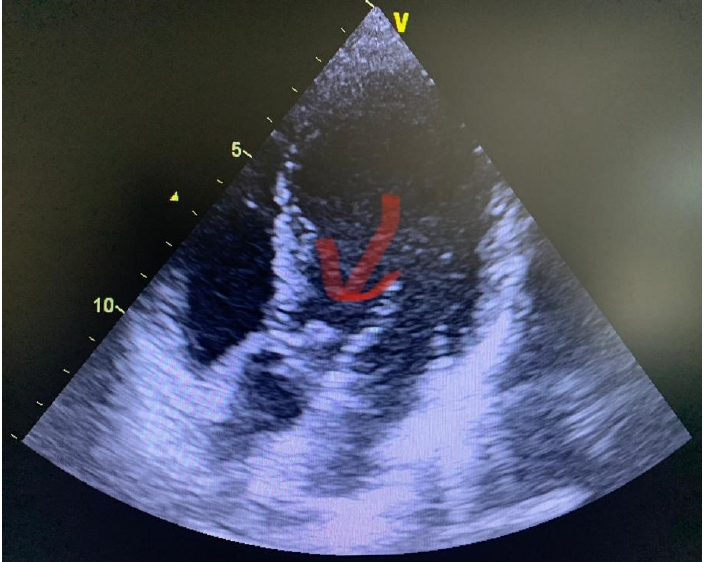
Figure A1. Transthoracic Echocardiogram: Vegetation on aortic cusp related to infective endocarditis concomitant with COVID-19.